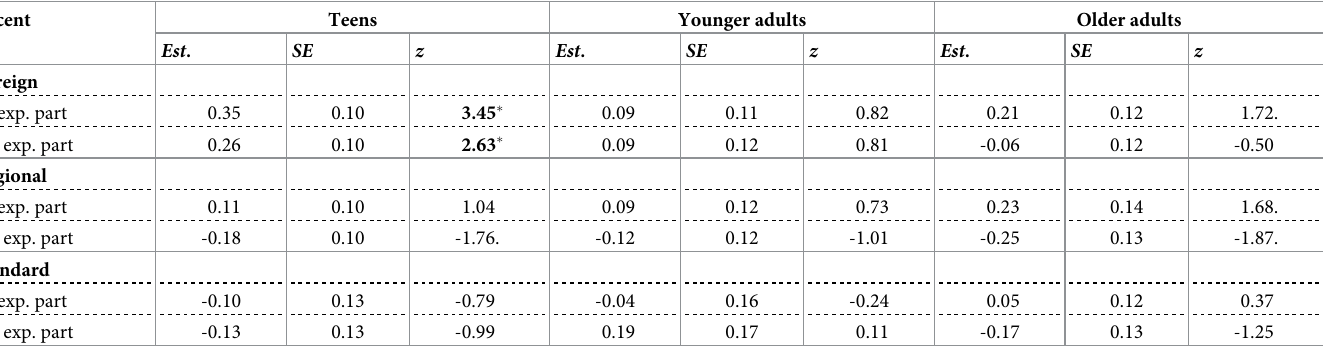
Table 2. Pairwise contrasts for sentence repetition accuracy.